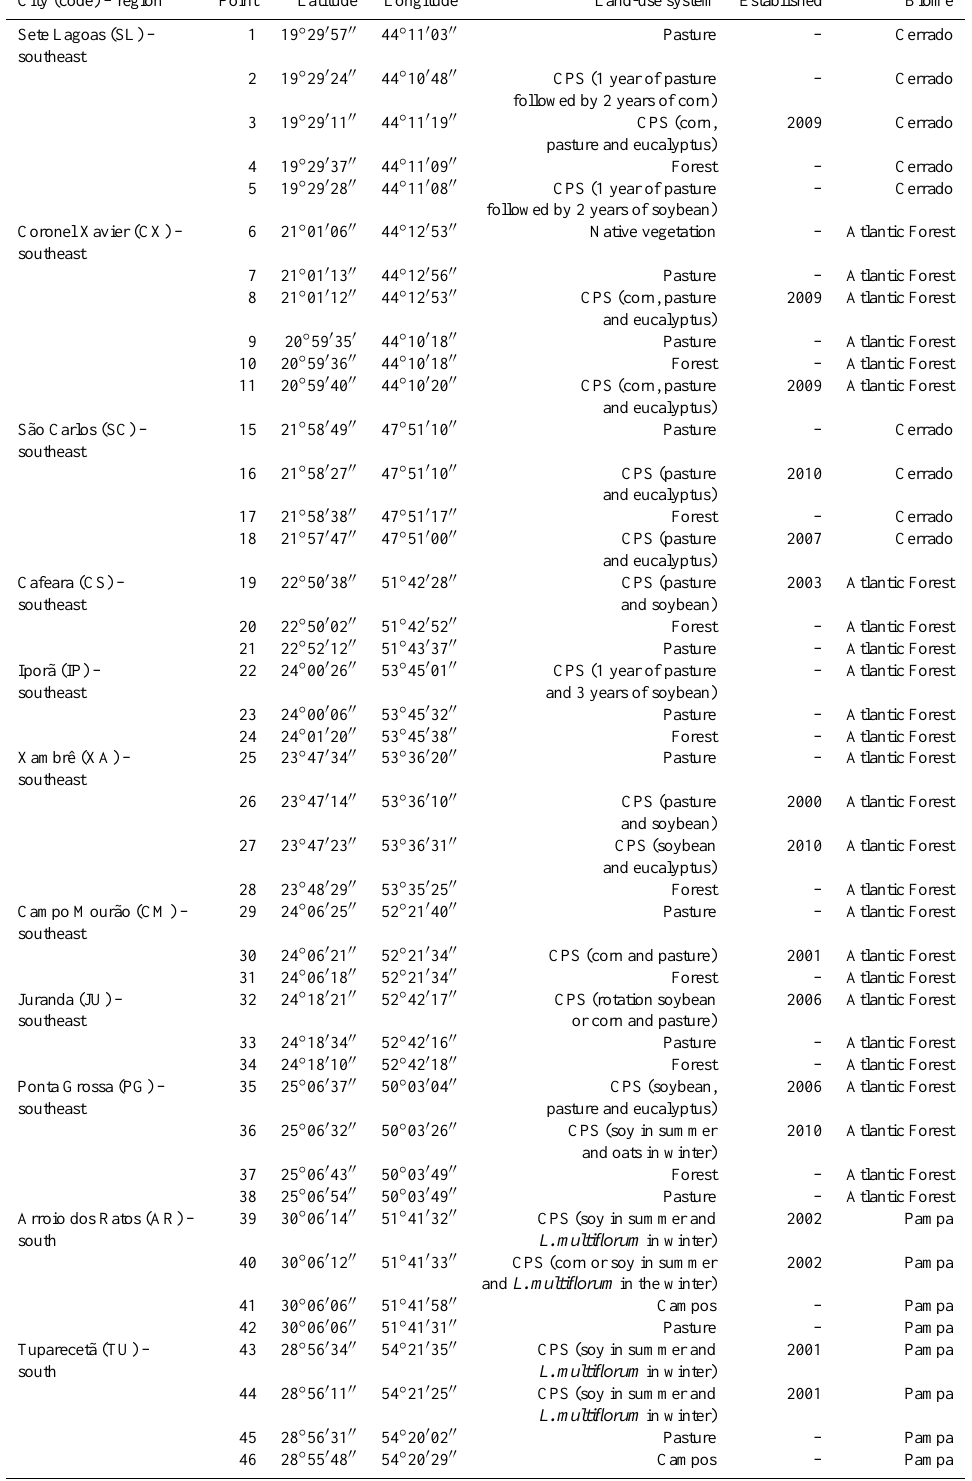
Table 1. Characterization of sampled sites: native vegetation (NV), pastures ( P ), crop–livestock systems (CPS). City (code) – region Point Latitude